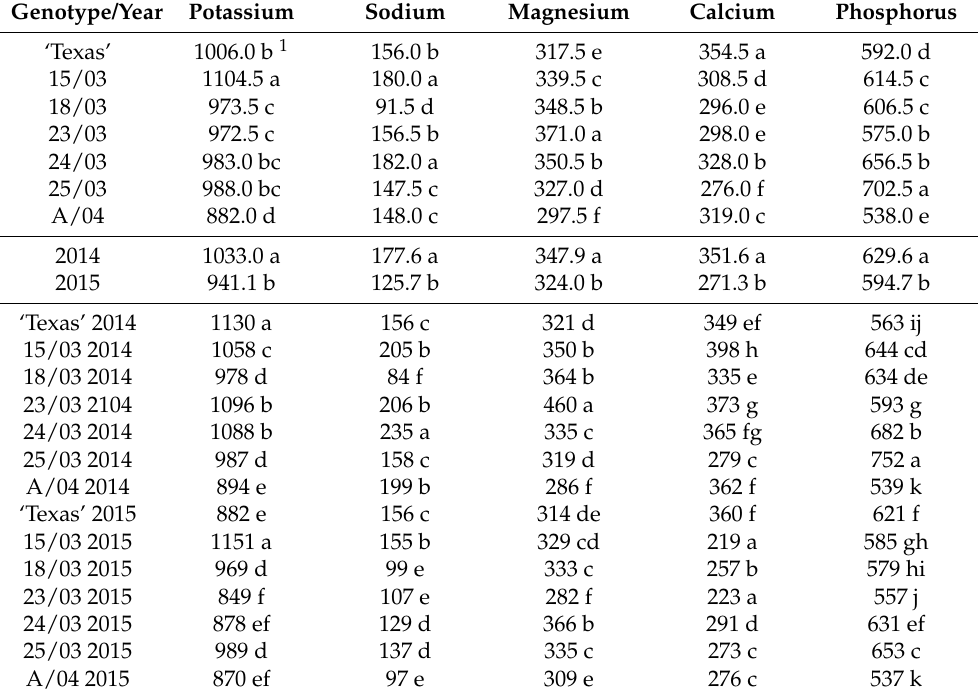
Table 5. The composition of the macro-elements (mg/100 g